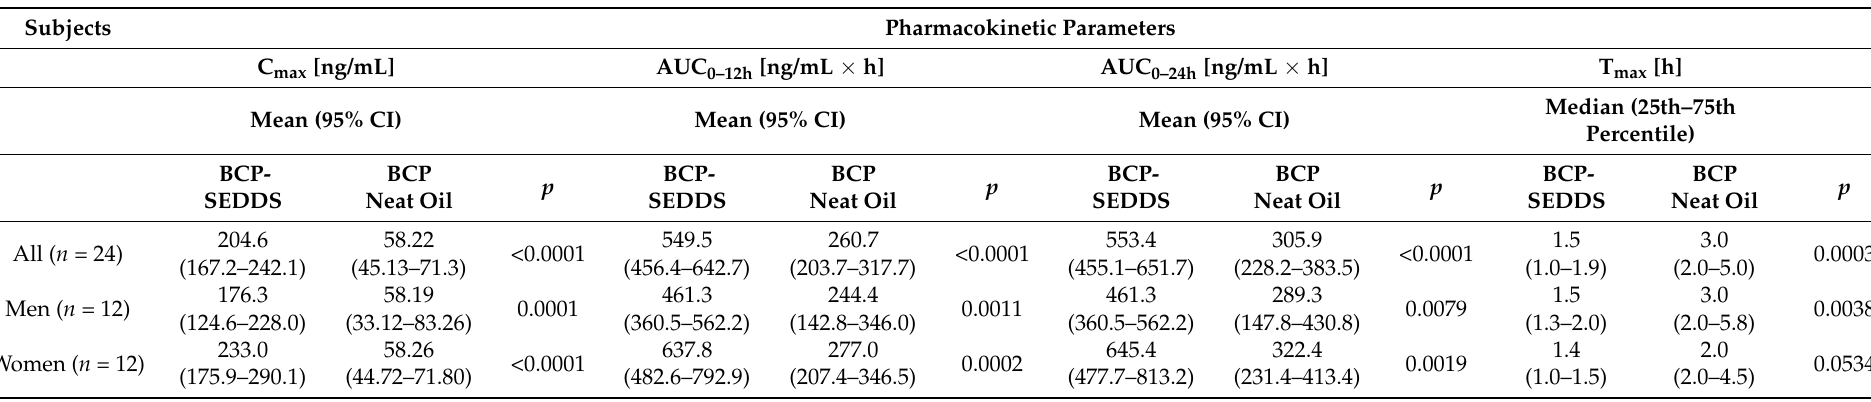
Table 2. Pharmacokinetic parameters of BCP after a single oral dose of 100 mg BCP administered as self-emulsifying drug delivery system (BCP-SEDDS) and as BCP neat oil (reference).